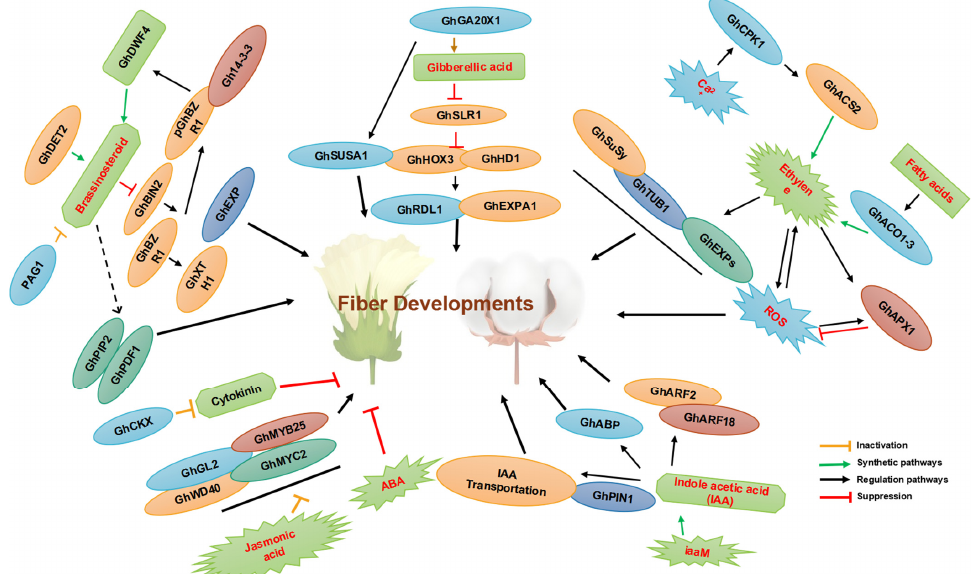
Figure 4. A diagram summarizing the roles of multiple phytohormones in cotton fiber initiation. A schematic model showing the roles of various phytohormones during cotton fiber development. Arrows show promoting actions, and blocked blunted lines show inhibitory actions. Yellow lines indicate the inactivation pathway, green lines indicate the synthetic pathway, black lines indicate the regulatory pathway, and red lines indicate suppression.